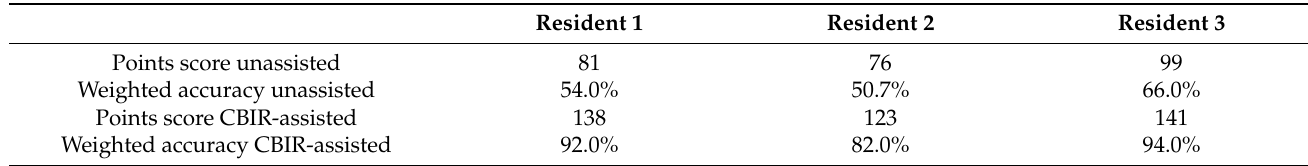
Table 4. Results of the residents’ weighted accuracy. Point scores are out of a maximum of 150. All residents’ weighted accuracies in the unassisted test runs proved to be significantly different ( p < 0.01) from the CBIR-assisted test runs.